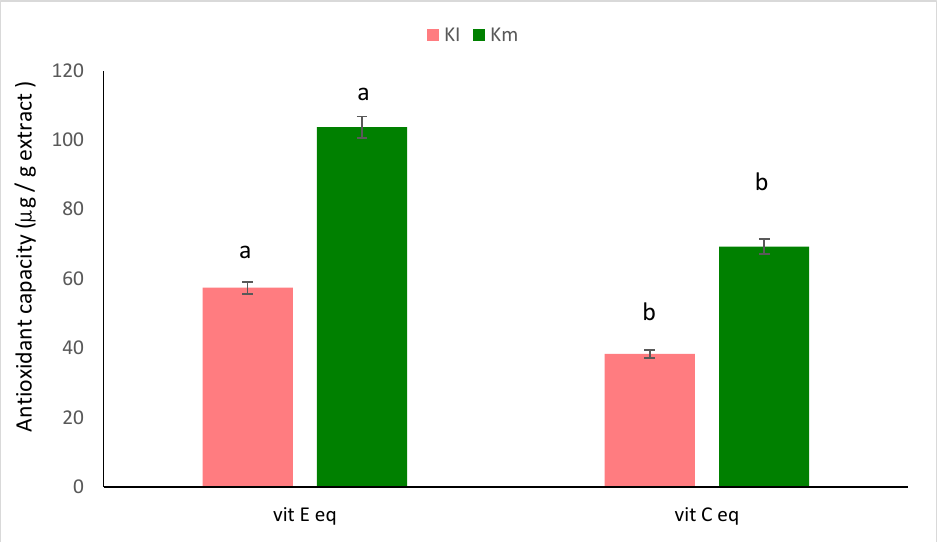
Figure 3. Antioxidant capacity of extracts of mature (K m ) and immature (K I ) fruits of K. pinnata . The values are the means of three replicates with standard deviation (±SD). Duncan’s multiple tests ( p ≤ 0.05) found no statistically significant differences between the values in each bar with the same letter. Vit E eq (vitamin E equivalent) and vit C eq (vitamin C equivalent).